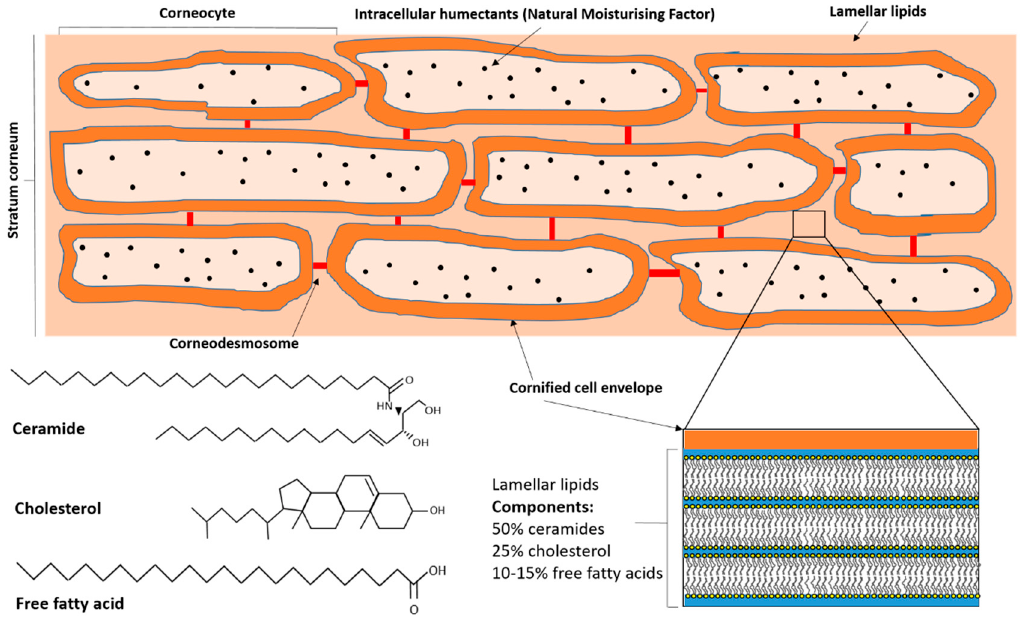
Figure 2. Schematic representation of the stratum corneum, with a view of the composition of the lamellar lipid layer. The typical chemical compositions of the major skin barrier lipids (ceramides, cholesterol and free fatty acids) are shown at bottom left.